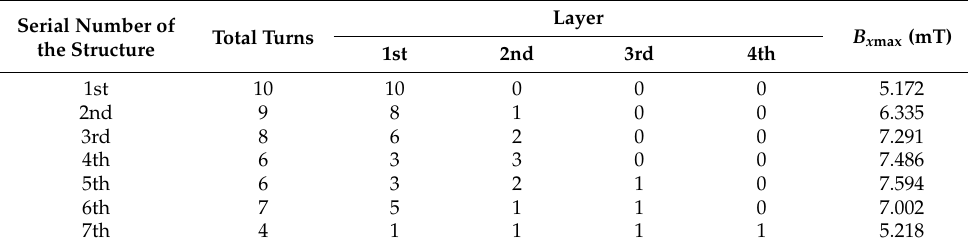
Table 5. The numerical correspondence between the structure of each winding of the magnetic fi eld coil and the maximum value of magnetic.